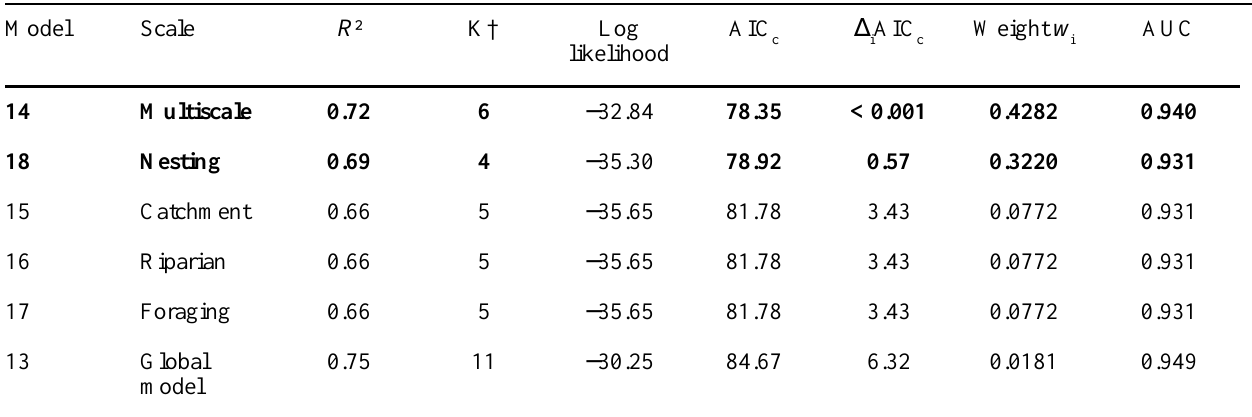
Table 5. Summary of results for ecoregion 3 (Southern New England Coastal Hills and Plain) habitat models with their associated Akaike weights. N = 133 lakes. Models with empirical support, i.e., D iAIC 2, are indicated in